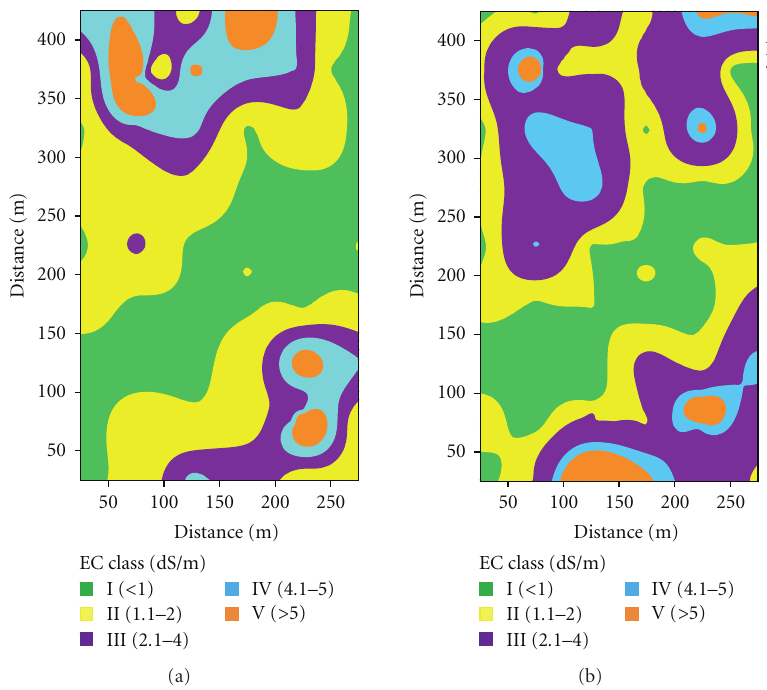
Figure 3: EC class spatial distribution contour map (a) 0–20 cm depth, (b) 20–40 cm depth during 2009. Table 3: Five classes of EC 1:1 , number of count in each class, area, mean, standard error (SE), median, coe ffi cient of variation (CV), kurtosis, skewness, range, minimum (min), and maximum (max) at 0–20 cm depth during 2009.